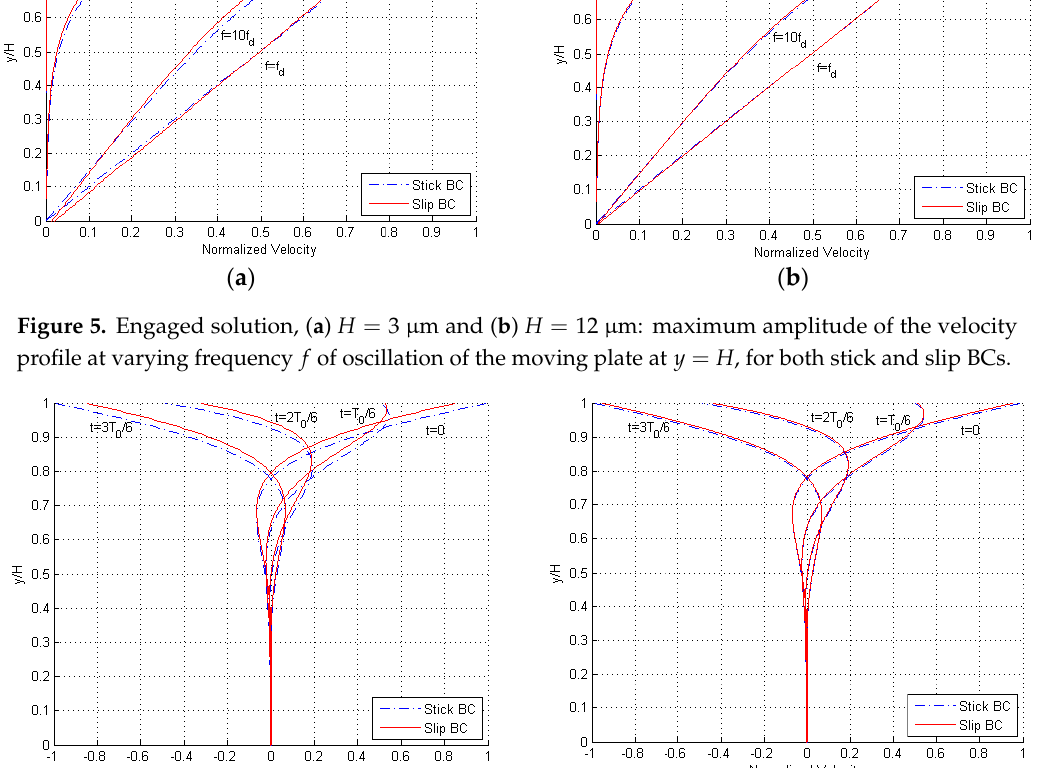
Figure 6. Engaged solution, ( a ) 𝐻 = 3 μm and ( b ) 𝐻 = 12 μm : snapshots of the velocity profile during